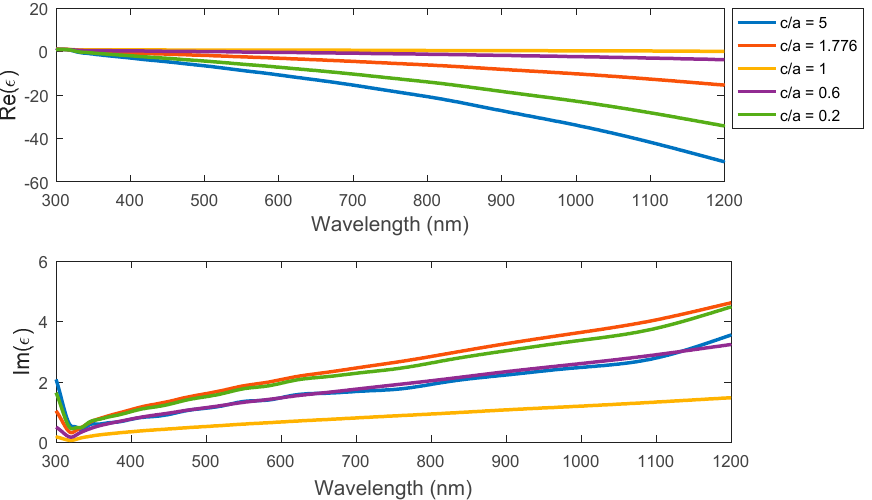
Figure 4. The permittivity for the ellipsoid, sphere, and spheroid in different (c/a) = 5, 1.667, 1, 0.6, 0.2.